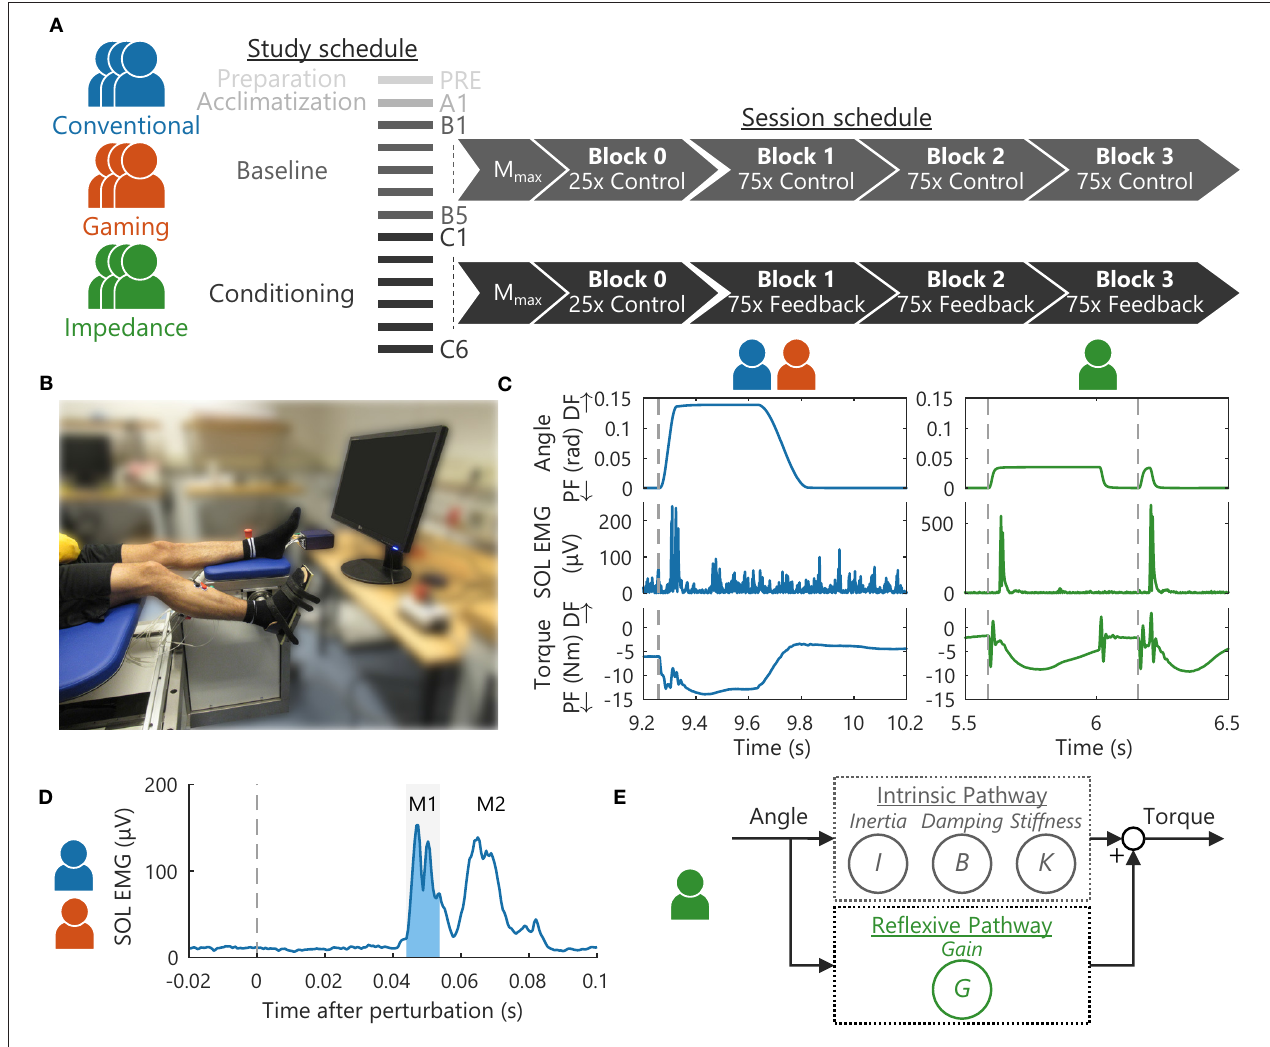
FIGURE 1 | Overview experimental methodology. (A) Nine participants were split in three groups, all following the same 13 session study schedule (3 times per week). Per session, M max was obtained using electrical stimulation, followed by 4 blocks with stretch reflexes containing either 25 or 75 feedback instances (7). (B) Stretch reflexes were elicited around the right ankle joint using a robotic manipulator. Participants were seated on an adjustable chair to support a static posture. (C) Dorsiflexion perturbations around the ankle joint elicited a stretch reflex response as visualized in the SOL muscle and torque. For the EMG-based groups, a discrete ramp-and-hold stretch profile was used (7), whereas a continuous pulse-step perturbation profile was applied for the Impedance group (14). (D) EMG-based groups received biofeedback on the SOL EMG, specifically background EMG activity and the short-latency (M1) reflex response (shaded area) (7). (E) The Impedance group received biofeedback on background torque and the estimated reflexive joint impedance gain ( G ). A mechanical-based methodology using recorded